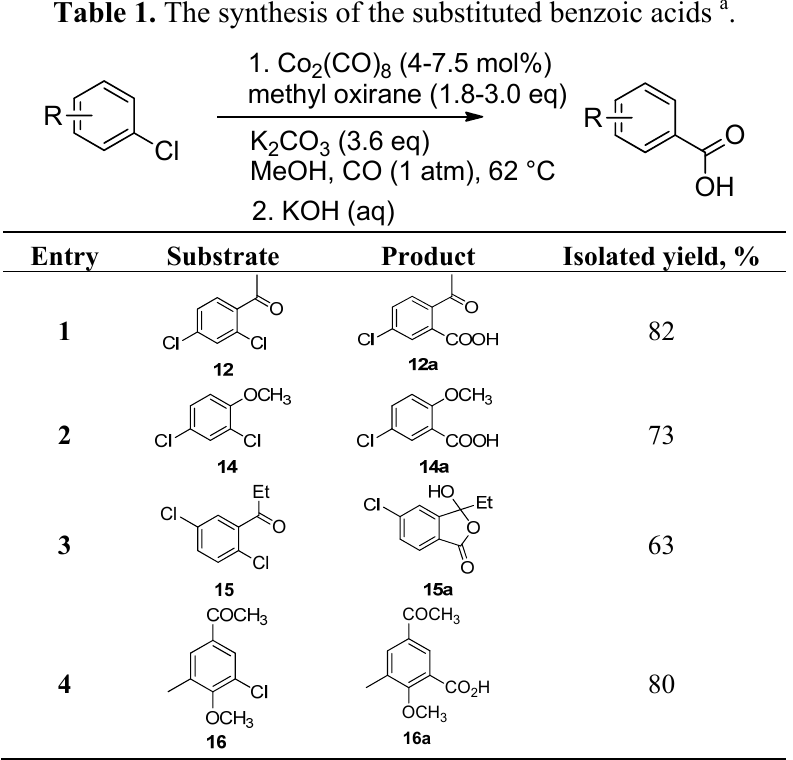
Table 1. The synthesis of the substituted benzoic acids a